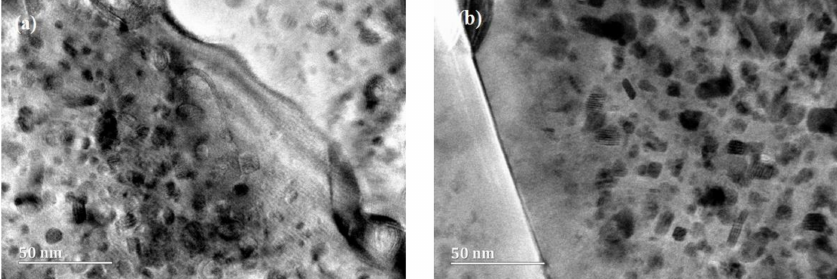
Figure 5. TEM image of precipitates adjacent to the grain boundary of the sample after different CTs: ( a ) 25 ◦ C and ( b ) − 120 ◦ C.